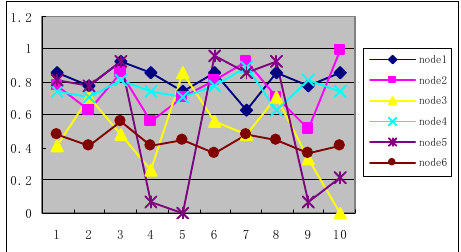
Fig.2. Package losing rate curve after normalization